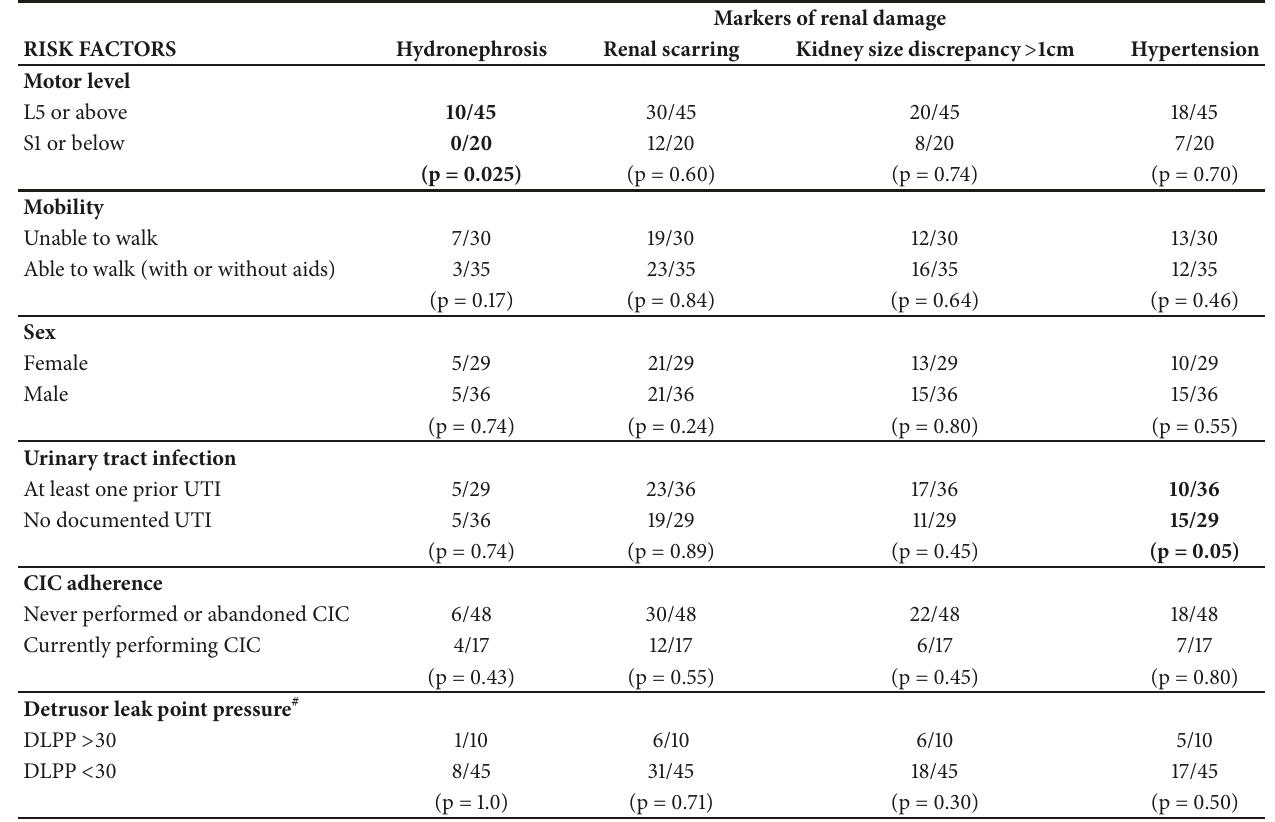
Table 3: Risk factors for renal